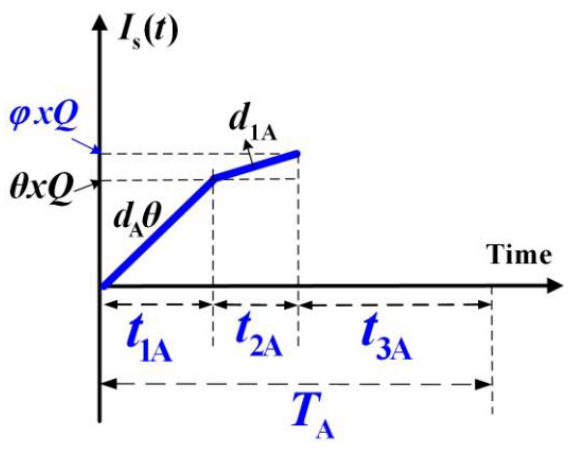
Figure 3. Status of scraps in the proposed